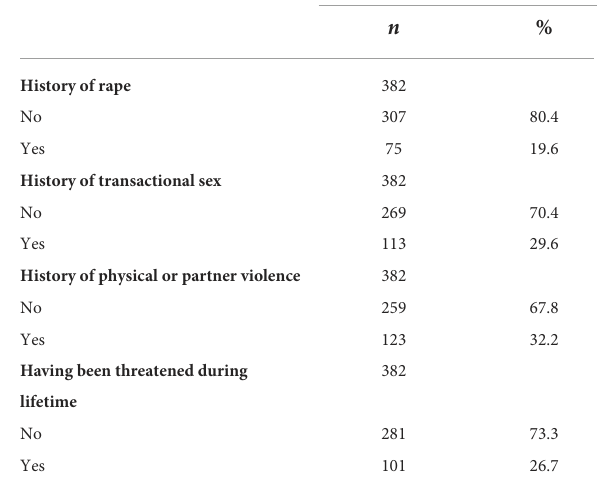
TABLE 1 Descriptive sociodemographic data of migrant women over 18 years of age consulting the French Red Cross Health and Prevention Centers in Cayenne and Saint Laurent du Maroni in 2021 ( n =